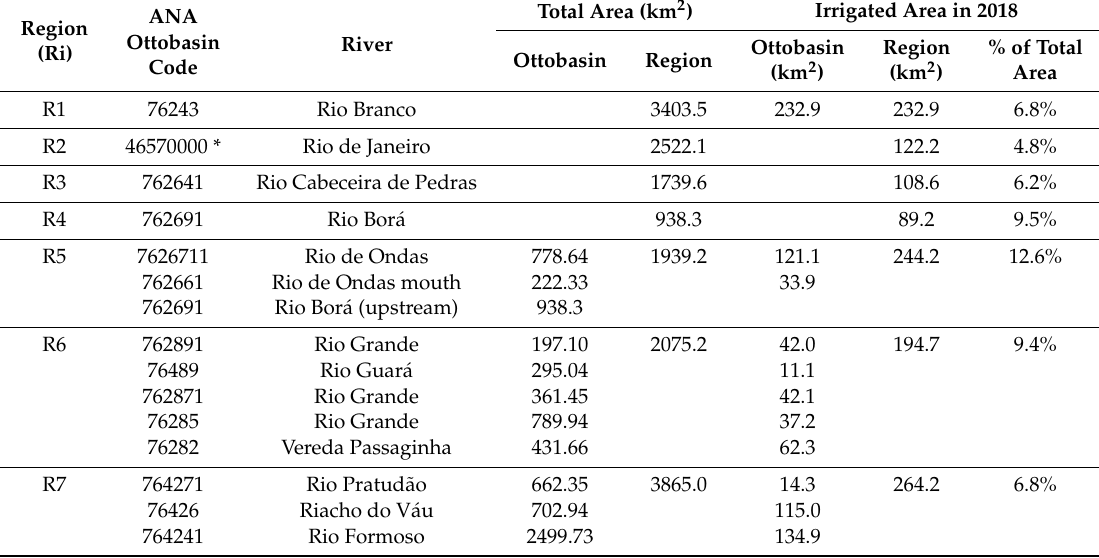
Figure 9. Evolution of irrigated area for selected regions for 2010 and 2018. Each center pivot ranges from 26.9 ha to 355 ha in area. The North–South scale of ( c ) and ( d ) is different than the same scale of ( a ), ( b ), ( e ), and ( f ). Table 2. Selected regions (R1–7) where irrigated area is located in Figure 9, with corresponding ANA Ottobasin codes. The region R2 coincides with the drainage area of station